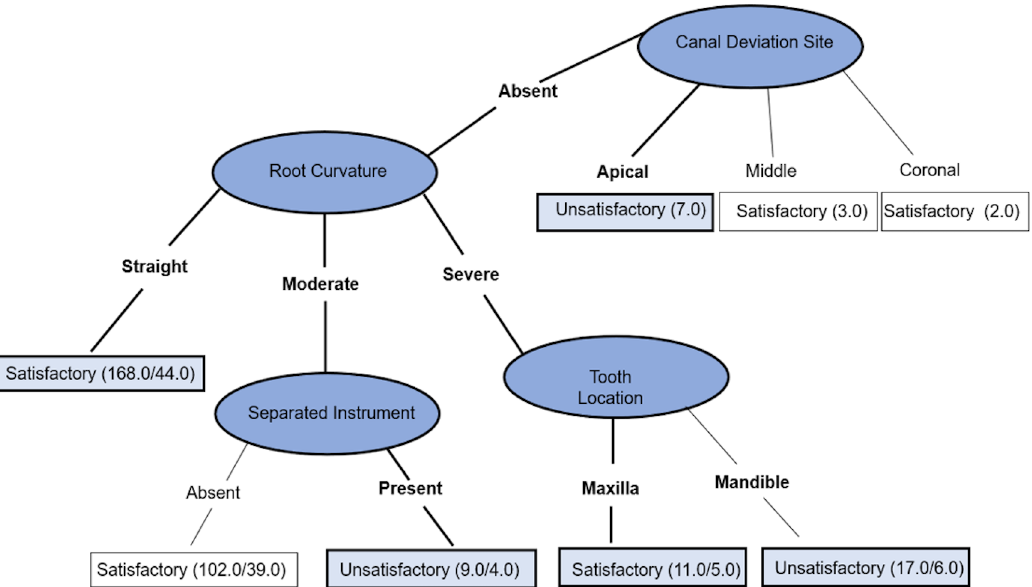
Figure 2- Decision tree A: Prediction of technical quality of non-surgical root canal retreatment, including variables related to diagnosis - (1) For canal deviation located in the apical third of the root, the technical quality of endodontic retreatment was unsatisfactory; (2) For absent canal deviation, severe RC, and tooth located in the mandible, the technical quality was unsatisfactory, whereas, for tooth located in the maxilla, the technical quality was satisfactory; (3) For moderate RC and separated instrument, the technical quality was unsatisfactory; (4) A straight RC immediately predicted that technical quality was satisfactory. The values in parentheses point out the total number of correctly/incorrectly classified instances in each leaf per node (Accuracy of 62.38%)